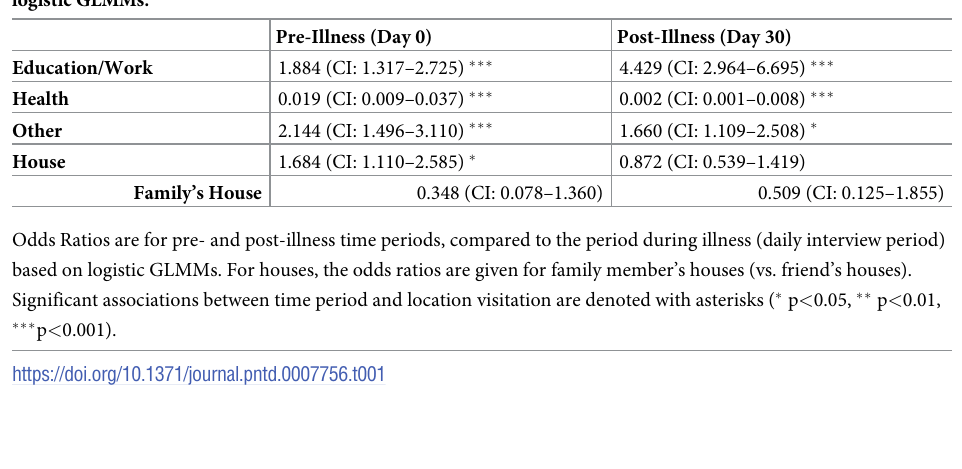
Table 1. Adjusted odds ratios (and 95% Confidence Intervals) for location type throughout illness, derived from logistic